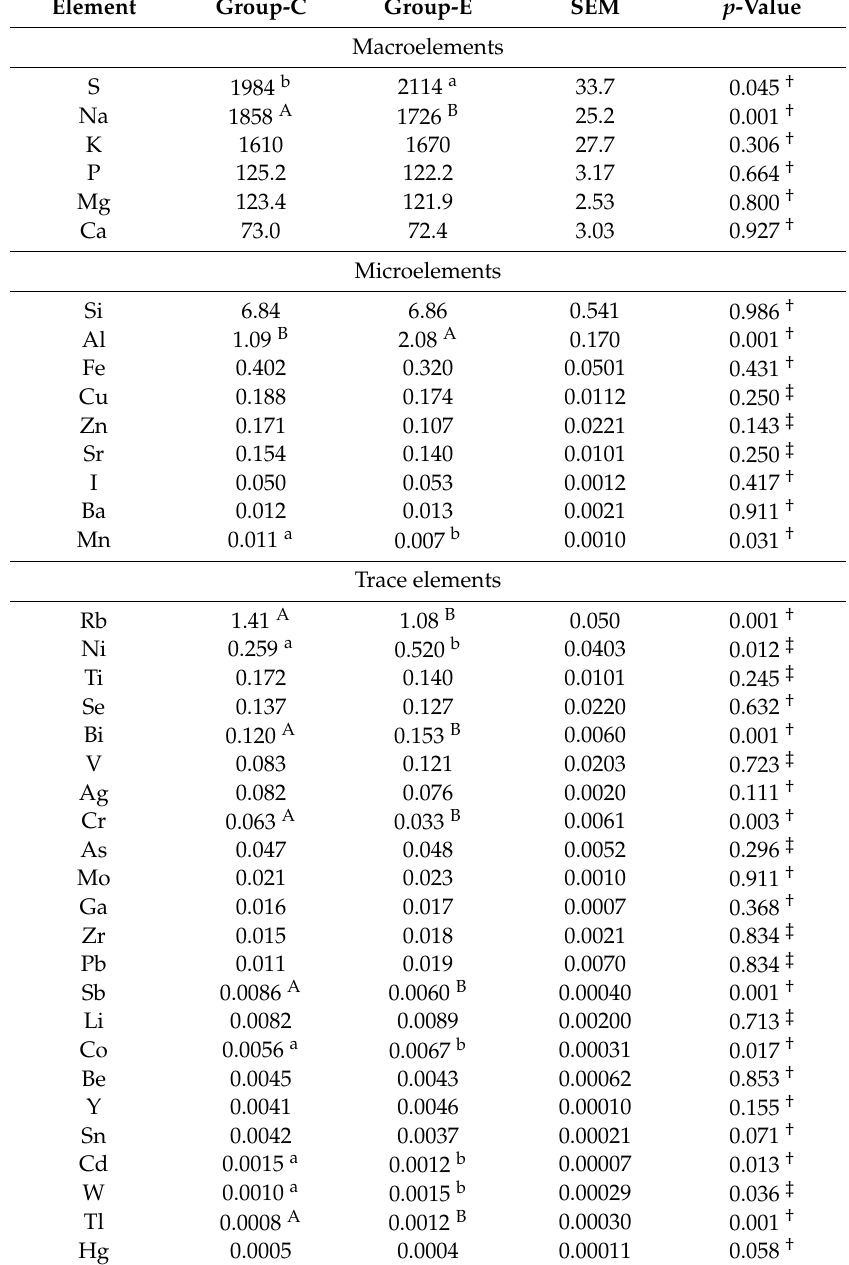
Table 3. The content of macro-, micro-elements and trace elements in the egg albumen. (mg / kg wet wt).